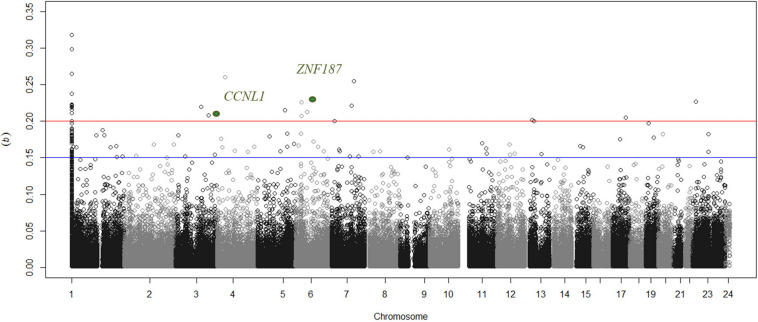
Manhattan plot showing distribution of delta beta values for uniquely mapped sites across all chromosomes. The blue line discriminates sites that have suggestive differences in methylation between cases with nephropathy compared to non-nephropathic individuals in the control group. Circles above the red line are loci where a substantial difference in beta values (>0.2) were observed and the two markers supported in the replication group are highlighted in green. Markers that are not uniquely mapped to a chromosome position based on Illumina’s updated bead pool manifest are assigned to chromosome 1 in this figure.